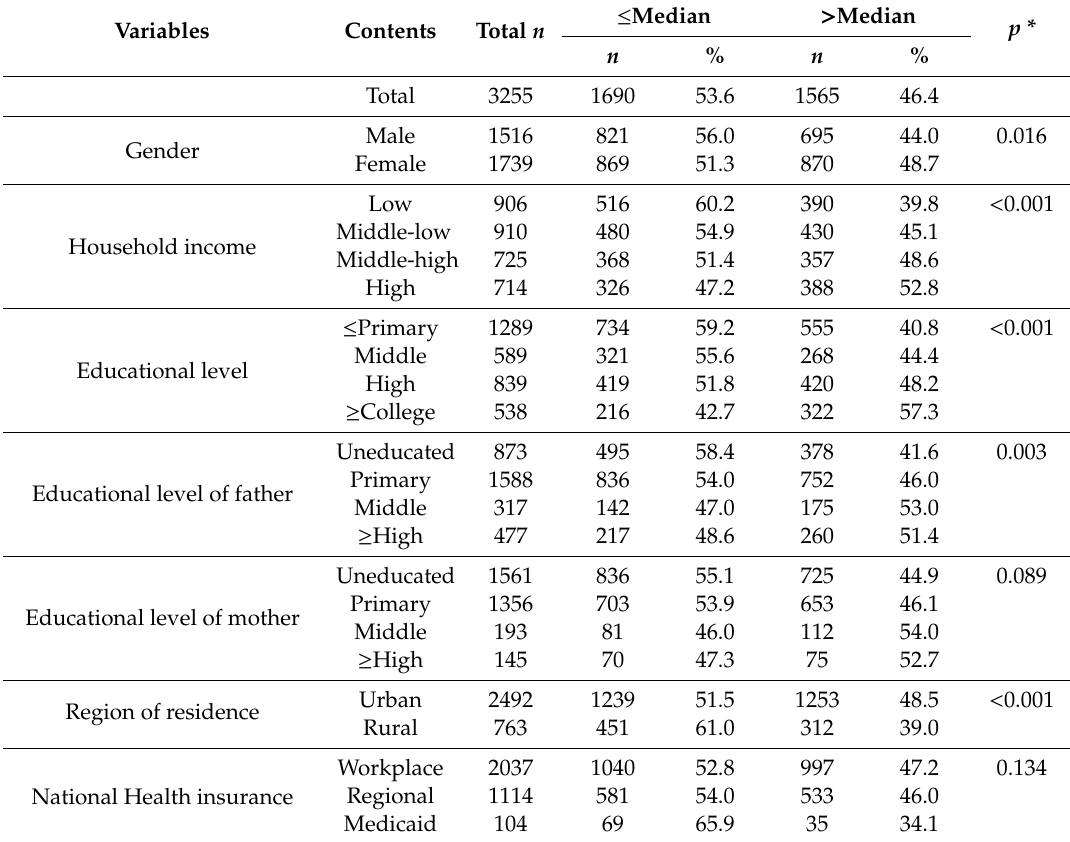
Table 3. Binary status based on the median number of existing teeth in the age groups by demographic, socioeconomic factors among the participants aged 55–79